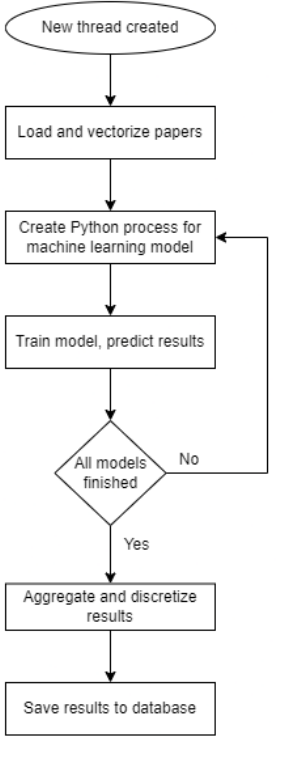
Figure 8. The process of selecting papers in the Litre Assistant system.